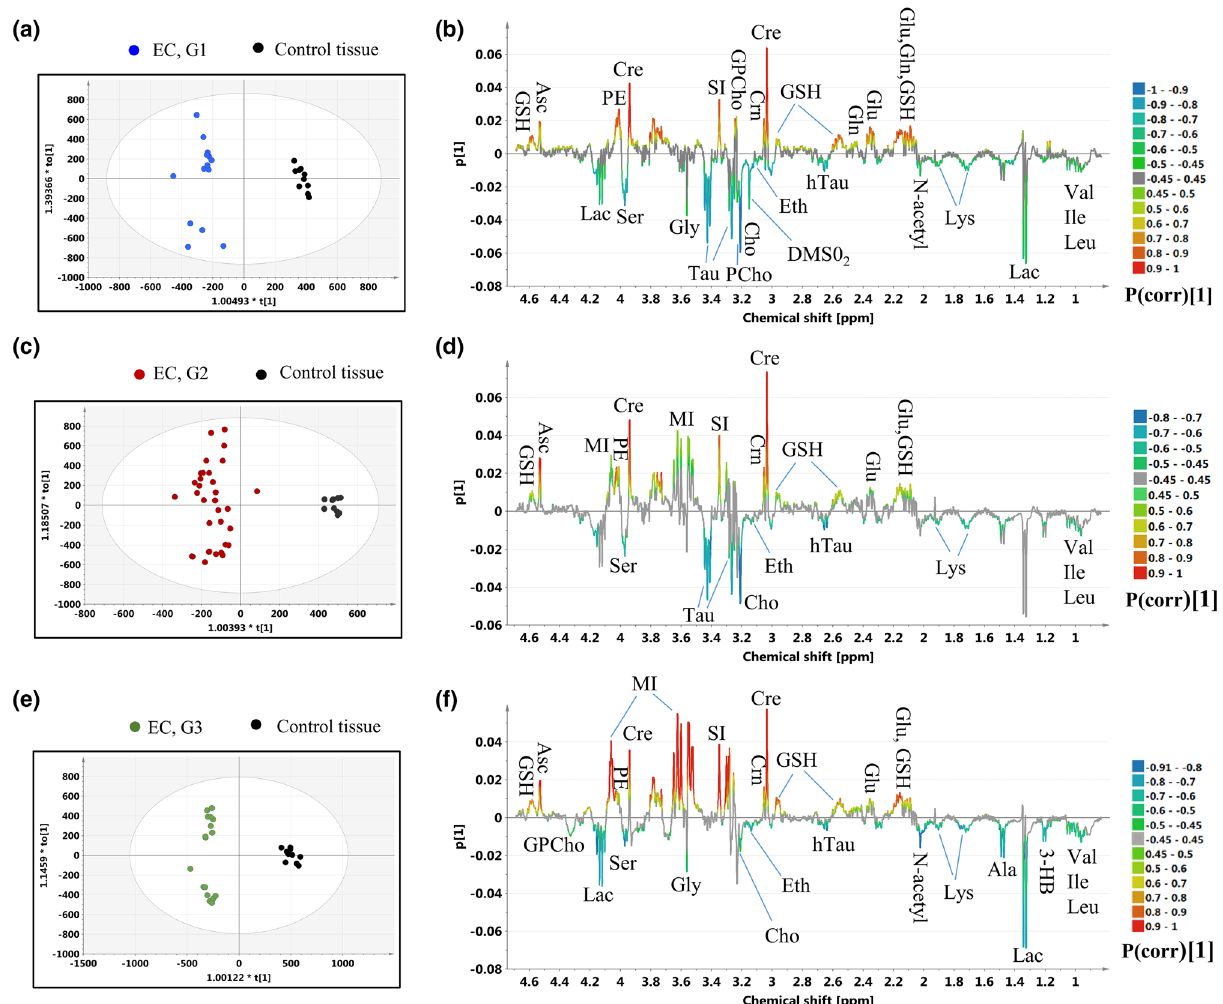
Figure 5. The OPLS-DA models: ( a ) the scores plot and ( b ) the loadings plot for the model 4, ( c ) the scores plot and ( d ) the loadings plot for the model 5, ( e ) the scores plot and ( f ) the loadings plot for the model 6. The color circles represent: black dot—a control tissue, blue dot—G1 EC, red dot—G2 EC, green dot—G3 EC. Val valine, Ile isoleucine, Leu leucine, 3-HB 3-hydroxybutyrate, Lac lactate, Ala alanine, Glu glutamate, Gln glutamine, GSH glutathione, Lys lysine, N-acetyl N-acetyl compound, hTau hypotaurine, Cre creatine, Crn creatinine, PCho phosphocholine, GPCho glycerophosphocholine, Cho choline, Eth ethanolamine, SI scyllo-inositol, Tau taurine, Gly glycine, MI myo-inositol, PE phoshoethanolamine, Ser serine, Asc ascorbate. The image was created using SIMCA-P 15.0 software package (https:// www. sarto rius. 4.33 ppm (corresponding to glycerophosphocholine) in the G3 tumors relative to the normal tissue, which is, however, not confirmed by the univariate statistics. Both approaches revealed increased taurine in the G1 and G2 tumors and elevated alanine in the G3 tumors as compared to the healthy tissue. Alanine was also found to be significantly increased in the G2 tumors in the univariate analysis. In turn, OPLS-DA shows the glycine level to be higher in the G1 and G3 tumors in comparison to the non-cancerous tissue, while the univariate analysis revealed the trends towards the increased glycine levels in these tumors (0.06 < p < 0.08). The OPLS-DA tech- nique shows myo-inositol in the G2 and G3 tumors to be decreased relative to the value for the non-transformed endometrium, while the univariate analysis indicates that this change is specific for the G3 tumors. According to the results obtained from the OPLS-DA models, in the G1 and G3 tumors the lactate levels are increased, while the p(corr)[1] values for the G2 tumors are slightly lower than 0.45. The higher lactate levels (at 1.33 ppm) in the G2 and G3 tumors are also confirmed by the univariate analysis. The multivariate analysis reveals increased 3-hydroxybutyrate in the G3 tumors in comparison to the healthy tissue, while in the univariate approach this change is also observed for the G2 tumors. Although the univariate analysis shows a downward glutamine trend in endometrial tumors irrespective of tumor grade (p ~ 0.07), OPLS-DA shows this metabolite to be reduced only in the G1 tumors. Of note, the singlet at 3.15 ppm assigned to dimethyl sulfone was observed in the majority of the spectra acquired from the G1 tumors. This signal was not observed in the specimens obtained from the G2 and G3 tumors and from the healthy tissue. On the other hand, the signals at 3.27 and 3.92 ppm (corresponding